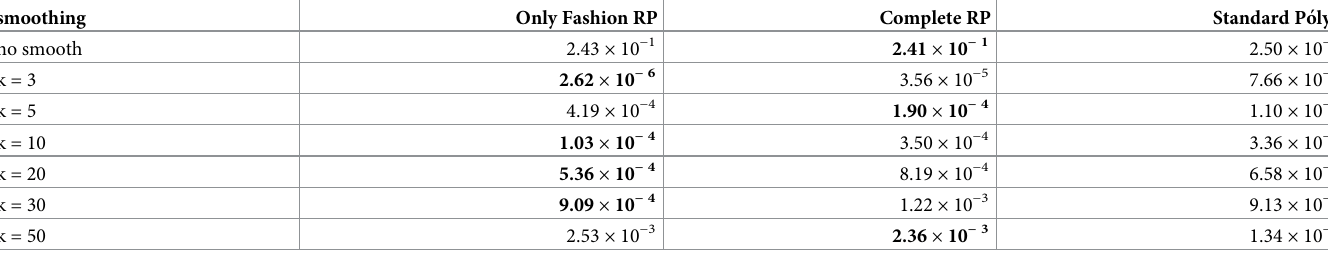
Table 8. “Migration” ( T = 0.35, only BOTs’ posts, D = 3 0 , S = 100 slots of equal size): MSE for different levels of smoothing. smoothing Only Fashion RP